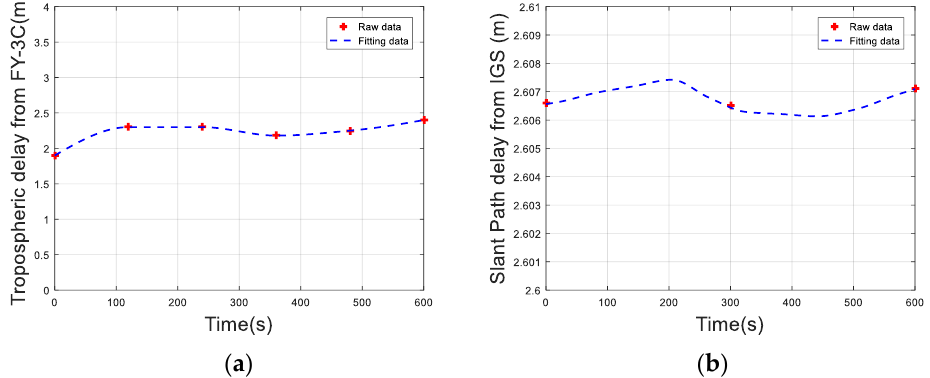
Figure 2. Tropospheric signal delay based on measured data: ( a ) atmospheric refractive index profile data from FY-3C and ( b ) tropospheric zenith delay data from IGS.